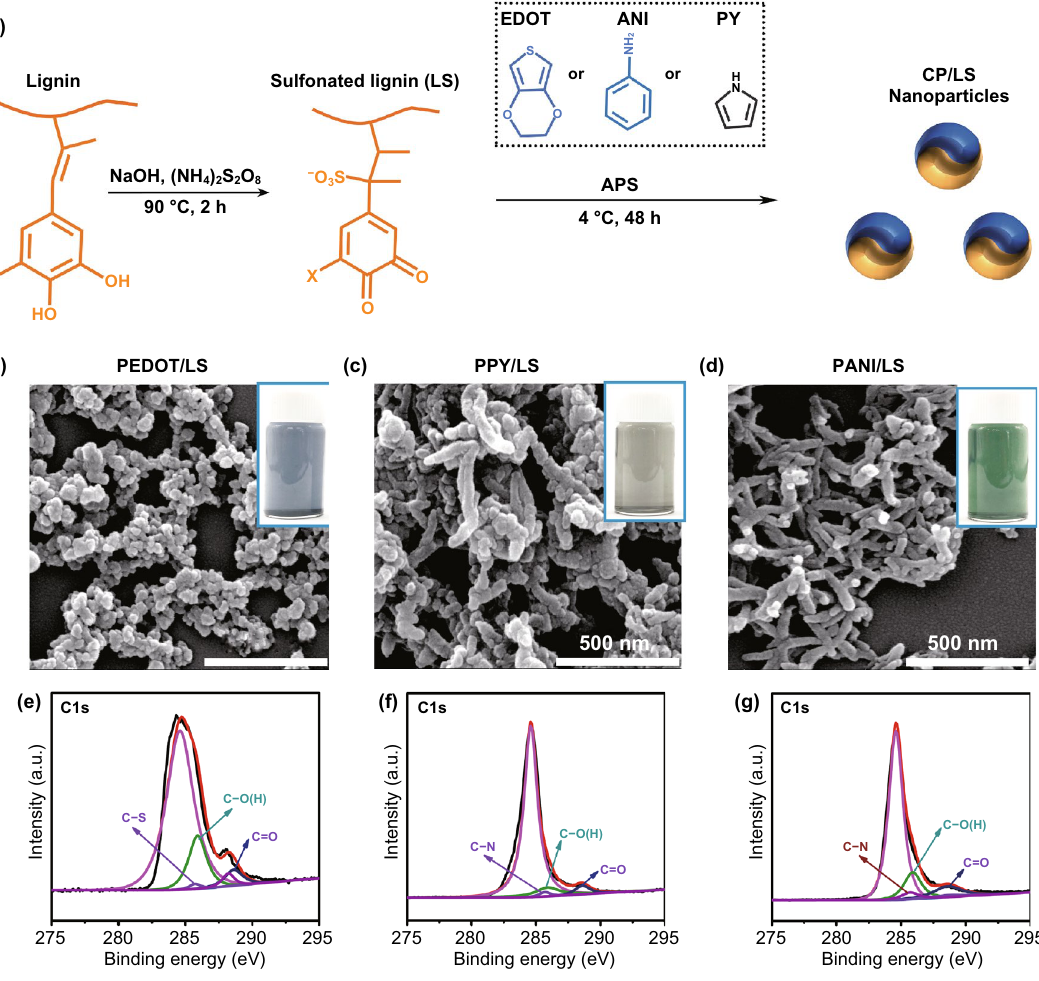
Fig. 2 Preparation and characterization of CP/LS NPs. a Preparation process of LS and CP/LS NPs. SEM images of b PEDOT/LS, c PPY/LS, and d PANI/LS NPs. The inset images showed the good water dispersibility of the various conductive NPs. XPS analysis of e PEDOT/LS, f PPY/LS, and g PANI/LS